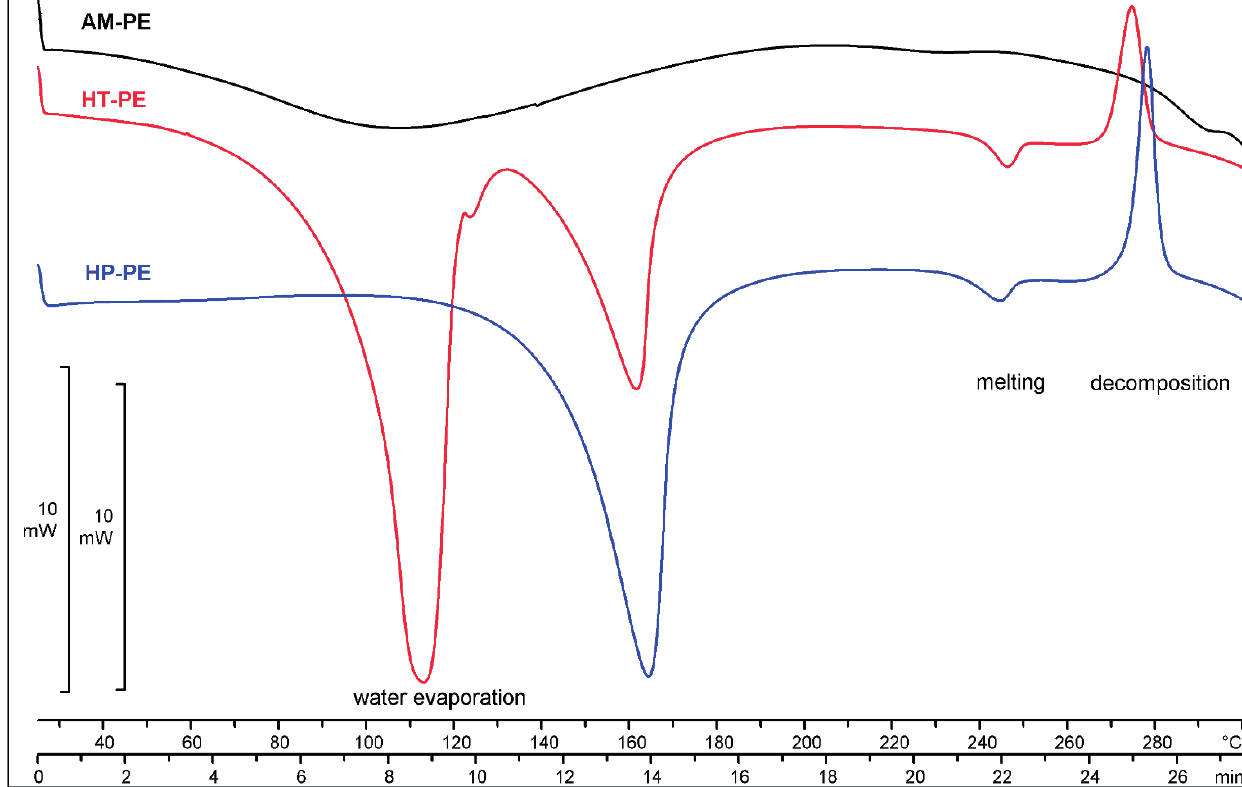
Figure 6. DSC profiles of HP-PE, HT-PE and